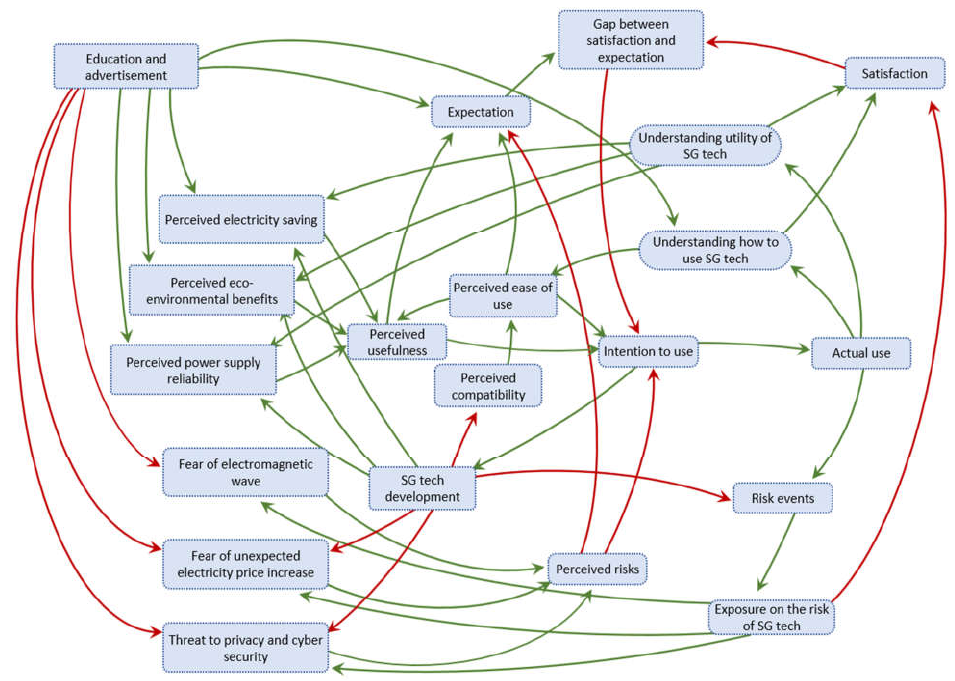
Figure 2. Acceptance model proposed by Park, Kim, and Yong (2017)